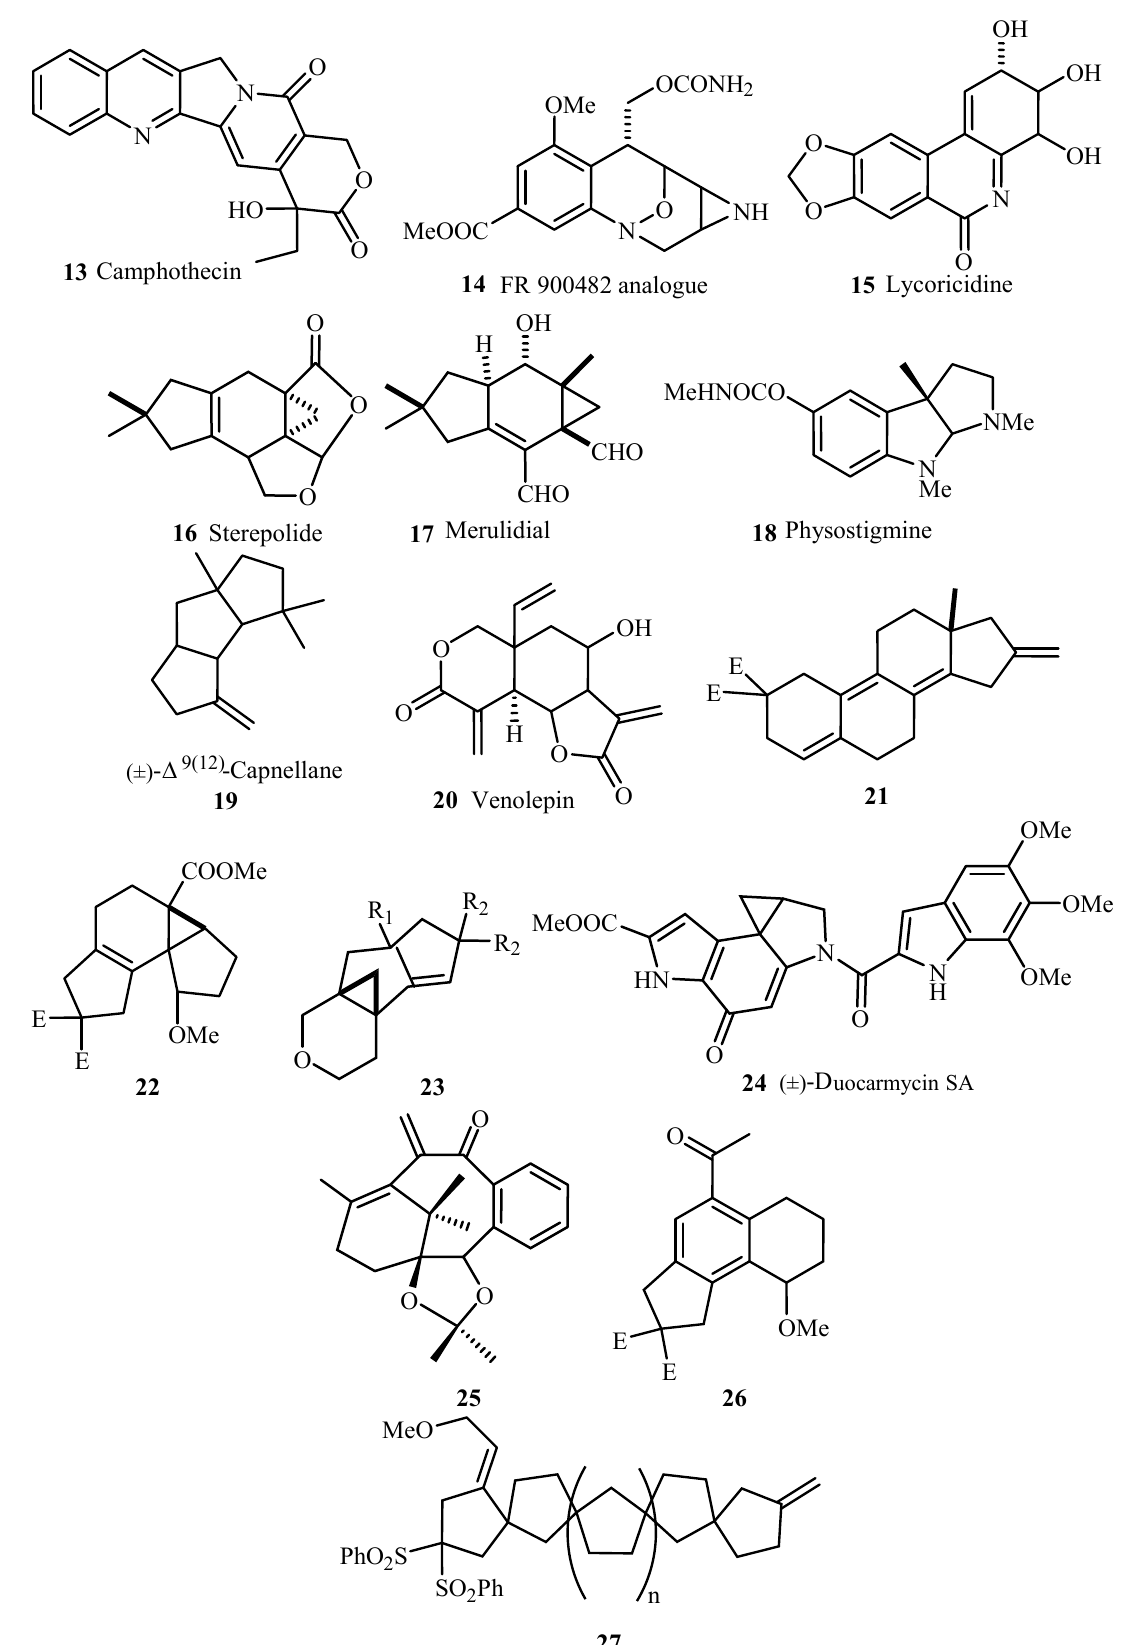
Figure 3. Natural products involving synthesis via different types of Heck transformations.